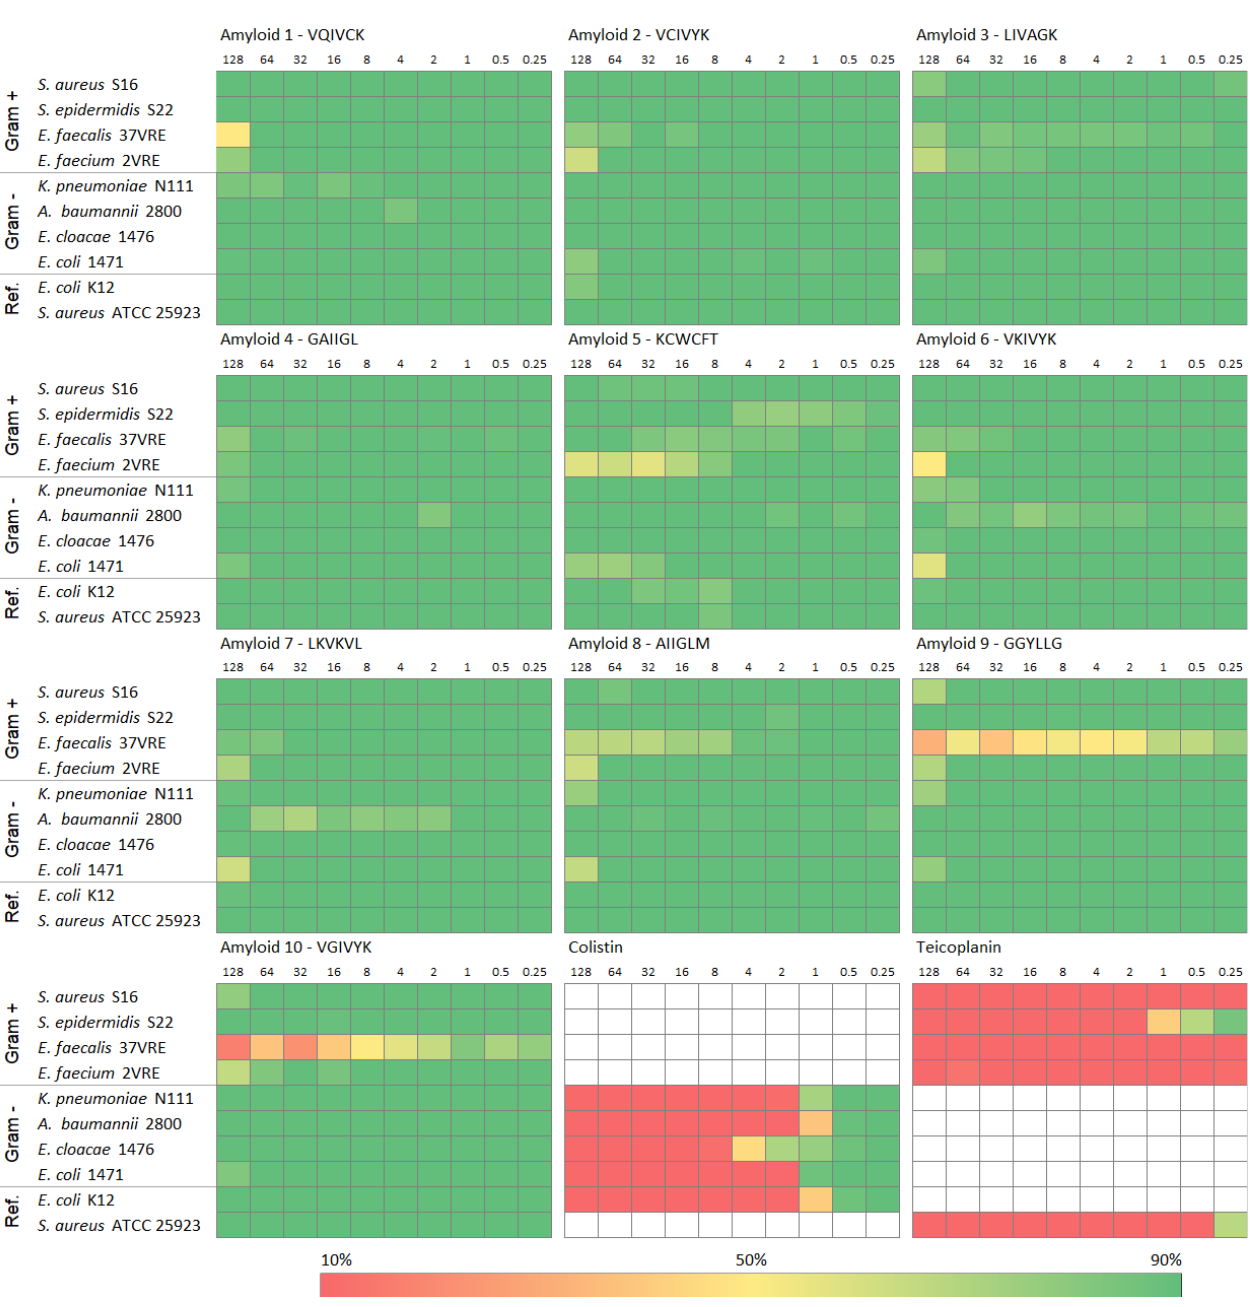
Figure 1. Experimental verification of the antimicrobial properties of short amyloids. Each of the 12 heat maps shows results for one amyloid or an antibiotic control. The columns represent the dilutions of the tested amyloids from 128 to 0.25 µ g/mL, and the rows bacteria used, including Gram-negative (Gram-), Gram-positive (Gram+), and the reference species (Ref.). The effect of amyloids on the bacterial viability is indicated as a color gradient from red (less than 10% bacteria survived), through yellow (~50% bacteria survived), to green (more than 90% bacteria survived). The detailed results are presented in the Supplementary